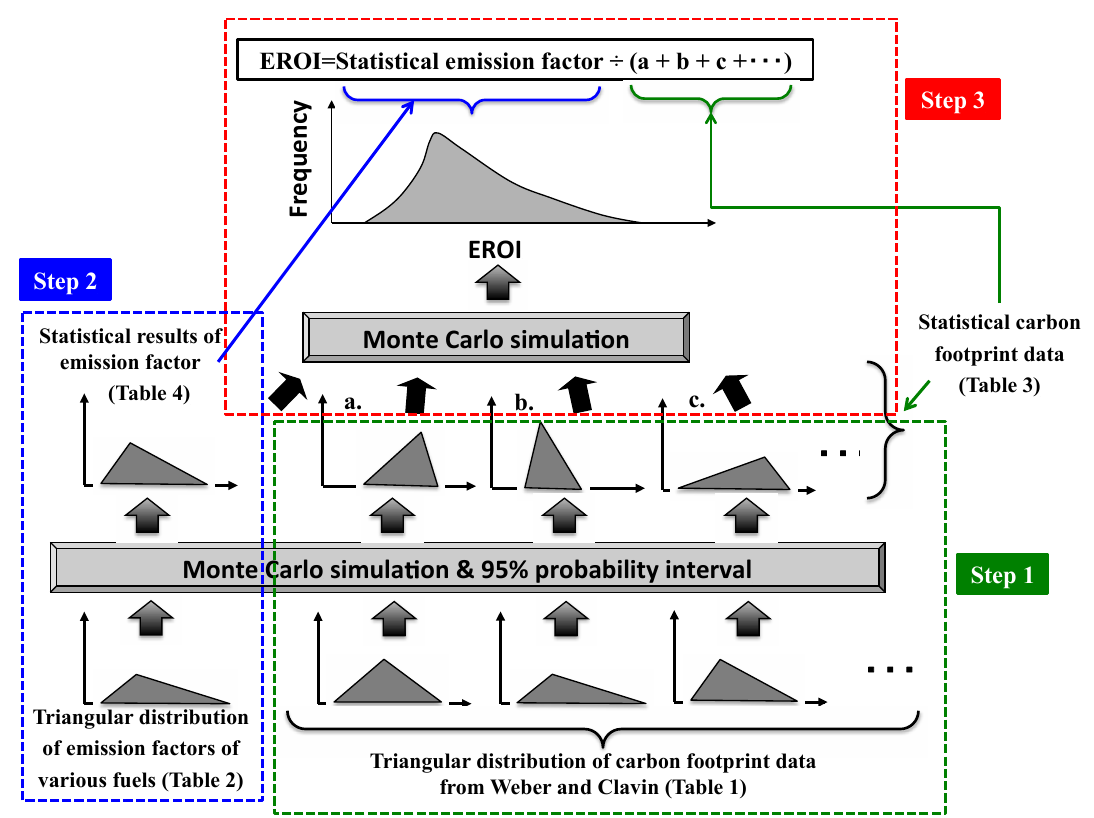
Figure 2. Schematic diagram of Monte Carlo Simulation for the estimation of EROI. In